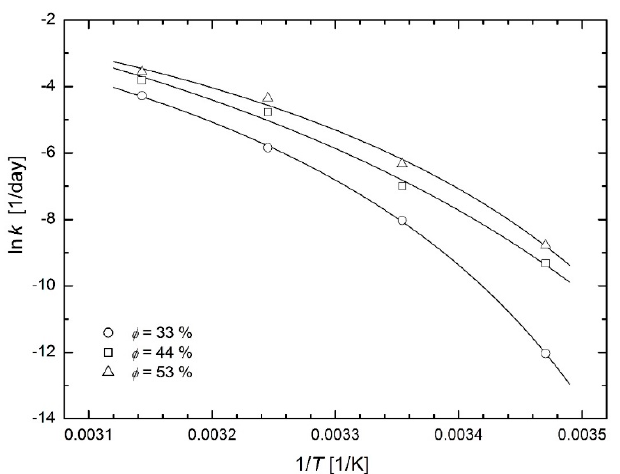
Figure 9. Modified Arrhenius plots for reaction rate constants of browning in freeze-dried onion at various relative humidity [24] (individual values of temperature T 0 for each relative